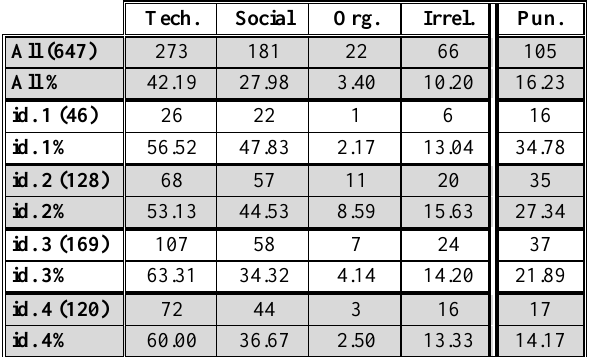
Table 11 : Improvement suggestion type by social group quantity Tech.